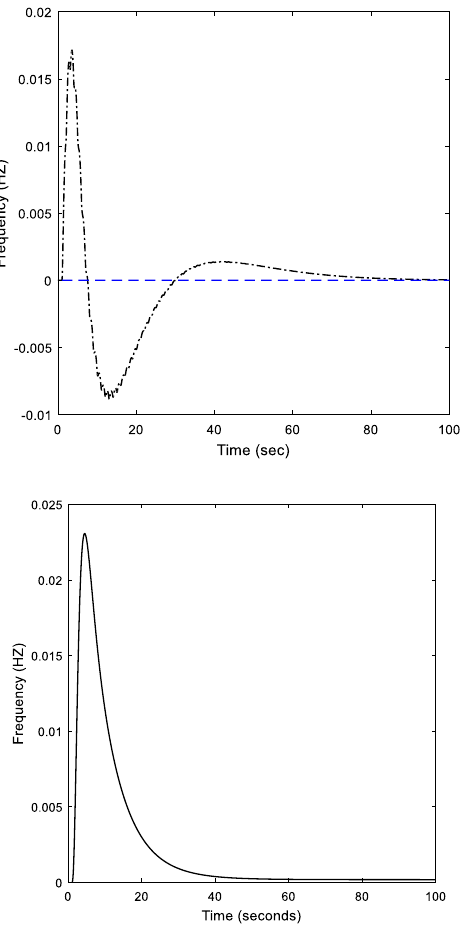
Figure 14. Closed Loop Time Response (top) and disturbance rejection (bottom).